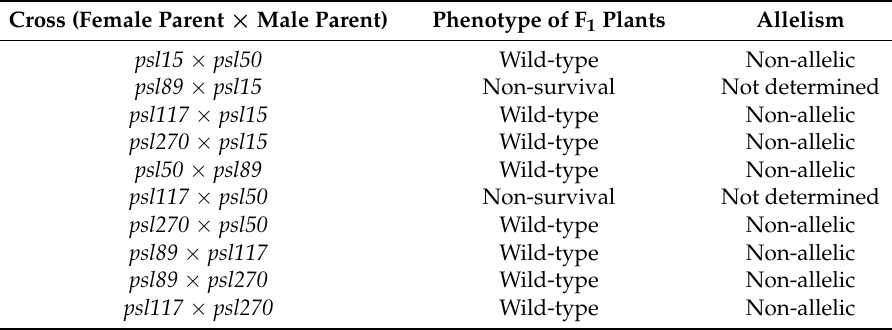
Table 3. Allelism test of premature senescence leaf